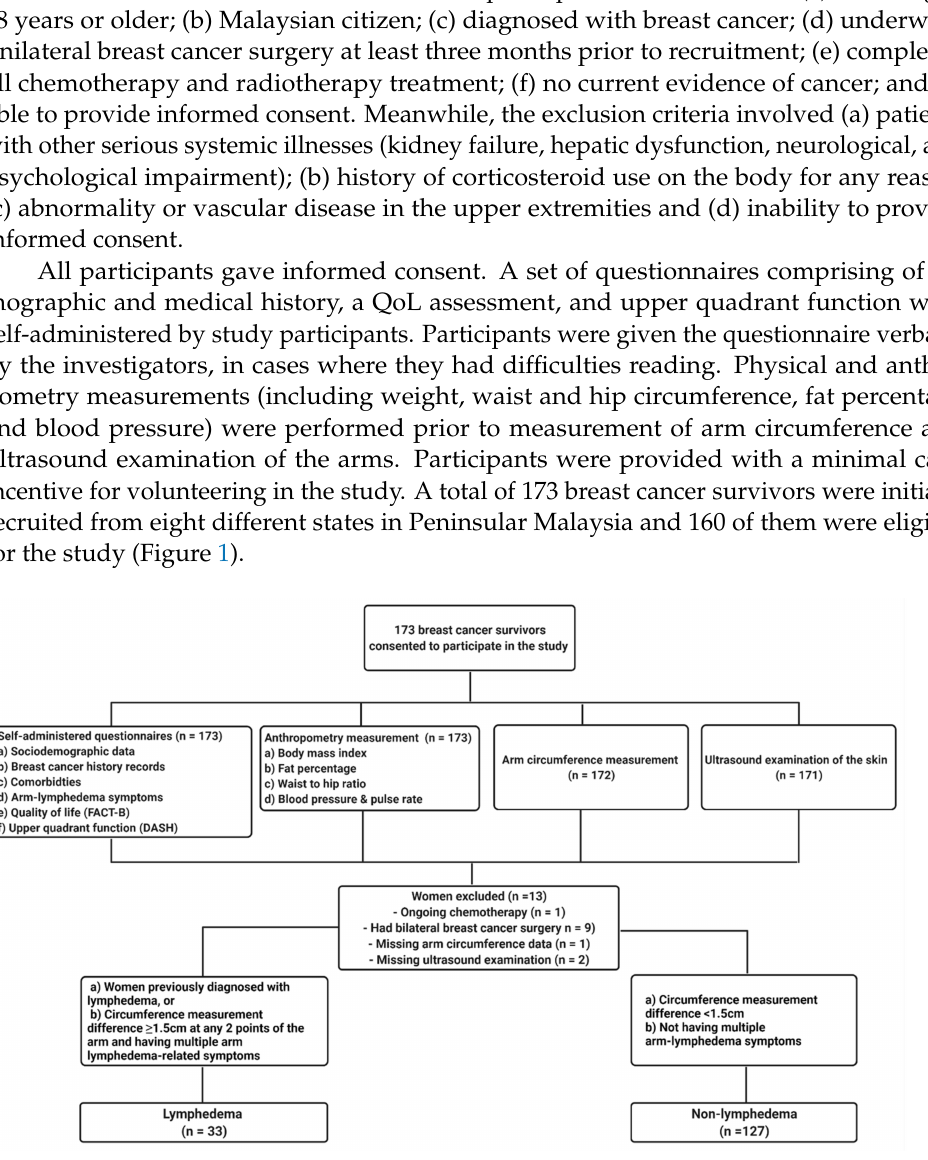
Figure 1. A flowchart of the recruitment and classification process of the breast cancer survivors in the study. FACT-B = Functional Assessment of Cancer Therapy—Breast. DASH = Disabilities of the Arm, Shoulder and Hand. CD = Circumference